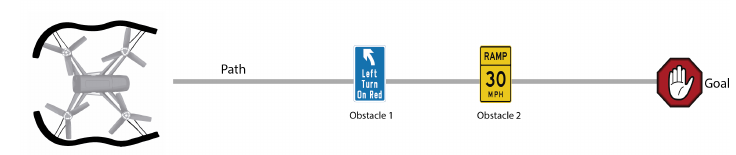
Figure 21. Distribution for two traffic sign-like obstacles.